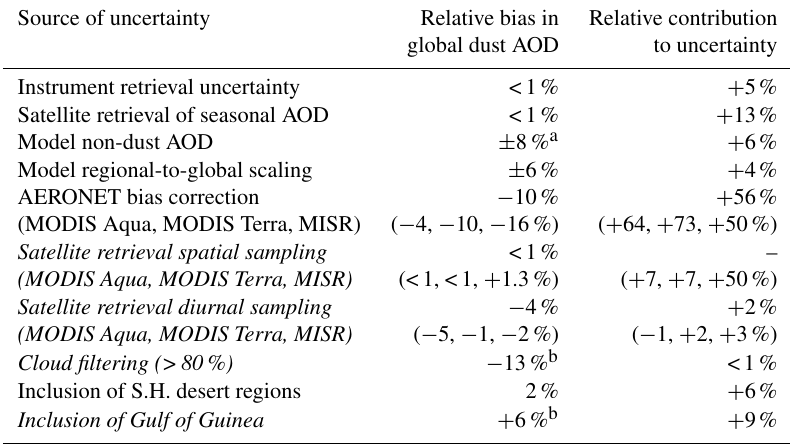
Table 2. Each source of uncertainty is assessed in terms of the impact upon the global dust AOD mean and standard deviation. The sign of the relative uncertainty indicates whether the uncertainty yields a bias about the average or is assumed symmetrical. For the model non-dust AOD and regional-to-global scaling the bias is defined as the difference between the upper and lower estimate of the global dust AOD when the source of uncertainty is isolated. Italicized uncertainties are explored but not incorporated into the global dust AOD uncertainty estimate. Values here are for correlated errors between neighboring 2 × 2.5 ◦ grid cells; assuming errors within a region are uncorrelated (i.e., a different number of sigma from the mean for each grid cell in an iteration) yields ∼ 8 × smaller uncertainty. Source of uncertainty Relative bias in Relative contribution global dust AOD to uncertainty Instrument retrieval